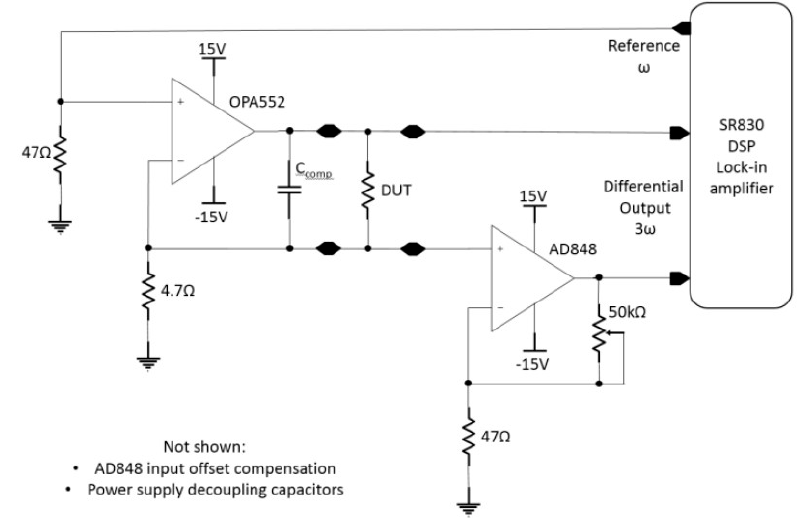
Figure 2. Custom electronics for 3 ω thermal characterization, including a high-power amplifier (OPA552) configured as a VCCS and a low-noise compensation amplifier